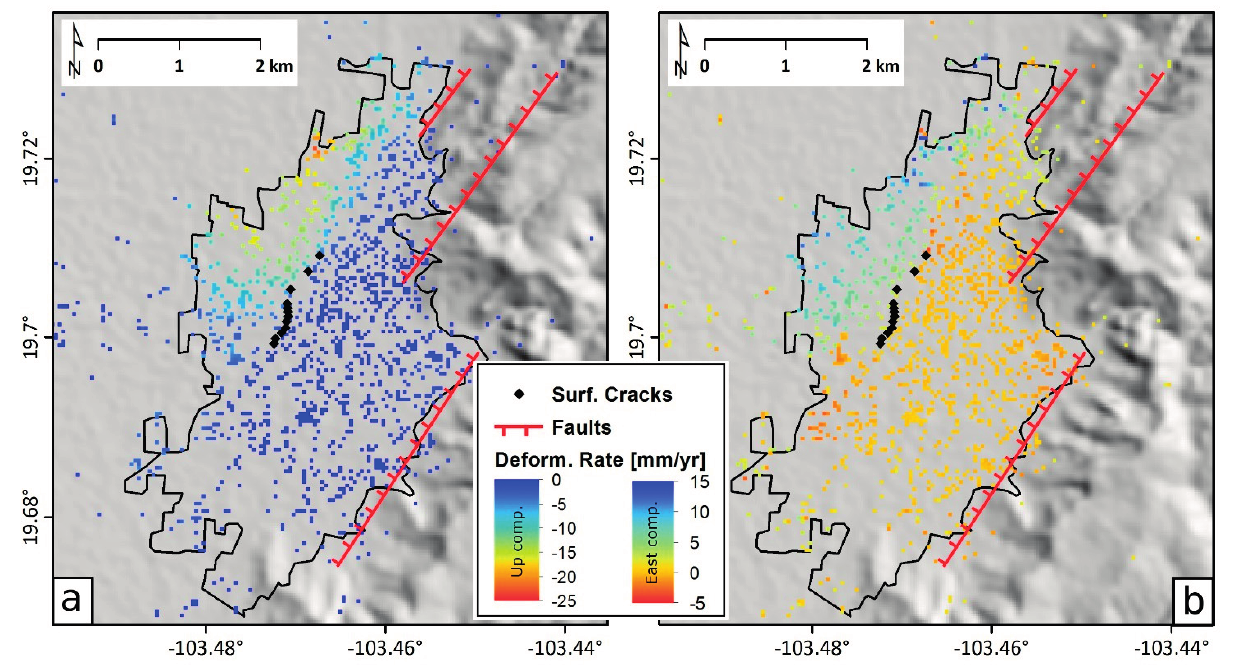
Figure 7. ( a ) Vertical deformation rate (negative values mean subsidence) and ( b ) east-west deformation rate (positive values mean eastward movement) computed from ascending and descending ENVISAT